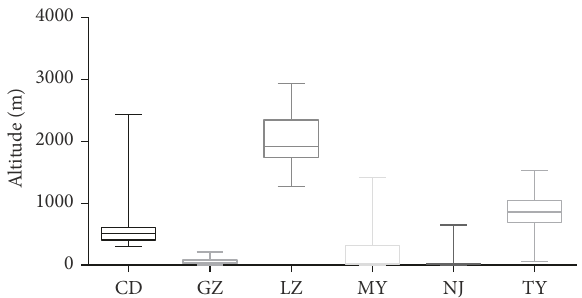
Figure 2: Box-and-whisker plots of altitudes for the six target stations and their neighboring